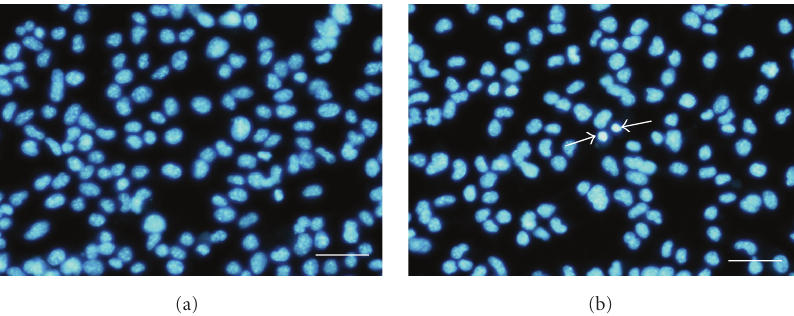
Figure 8: Hoechst 33342 staining to detect apoptotic changes. (a) Control group and (b) cFIR group. Scale bars = 50 μ m. Arrows indicate very small amounts of apoptotic changes (DNA condensation) in B16-F10 cells treated by cFIR for 48 h. considerably vary in human melanoma cells from di ff erent cell lines, and HSP70 levels in melanoma cells evidently contribute to their resistance to anticancer drugs